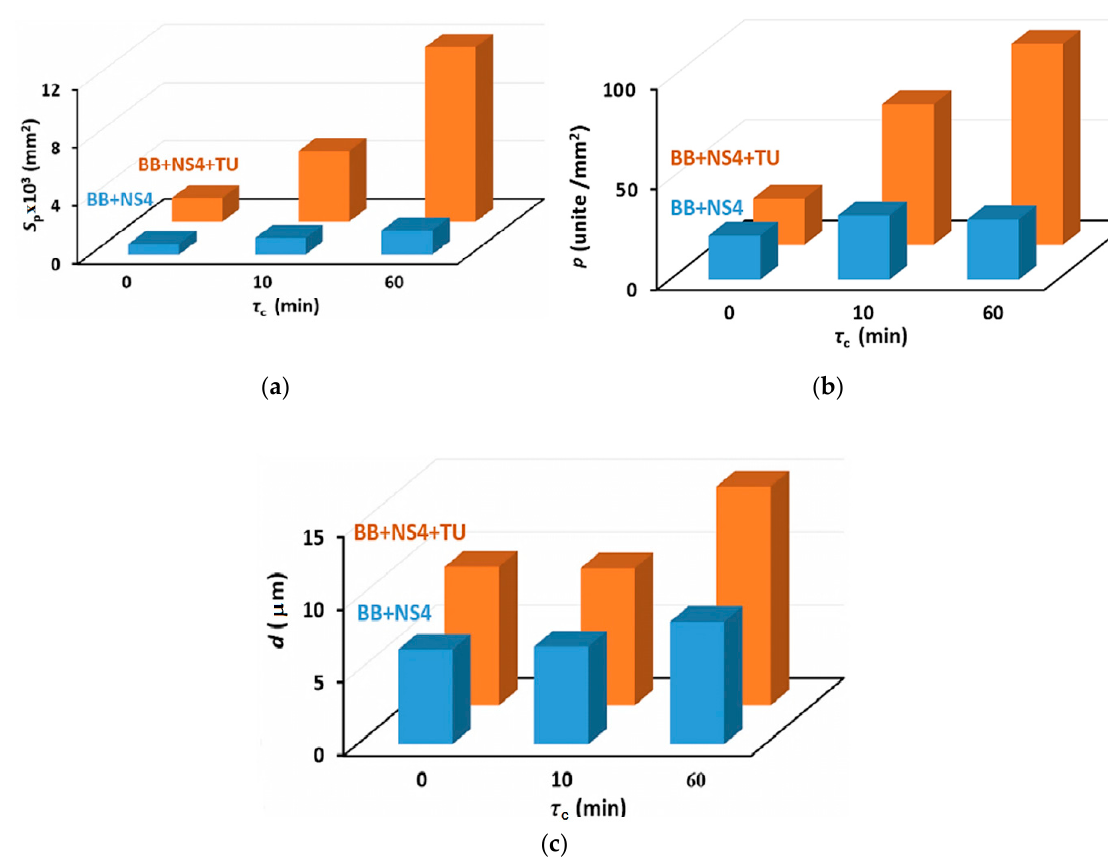
Figure 2. The effect of addition of 10 − 2 M of thiourea on the total pit area S p ( a ); pit density on the sample surface ( b ) and their average diameter d ( c ) versus duration of the cathodic period of the cycle in SACP. The setup consists from 72 cycles, the duration of anodic period of one cycle 3 min.